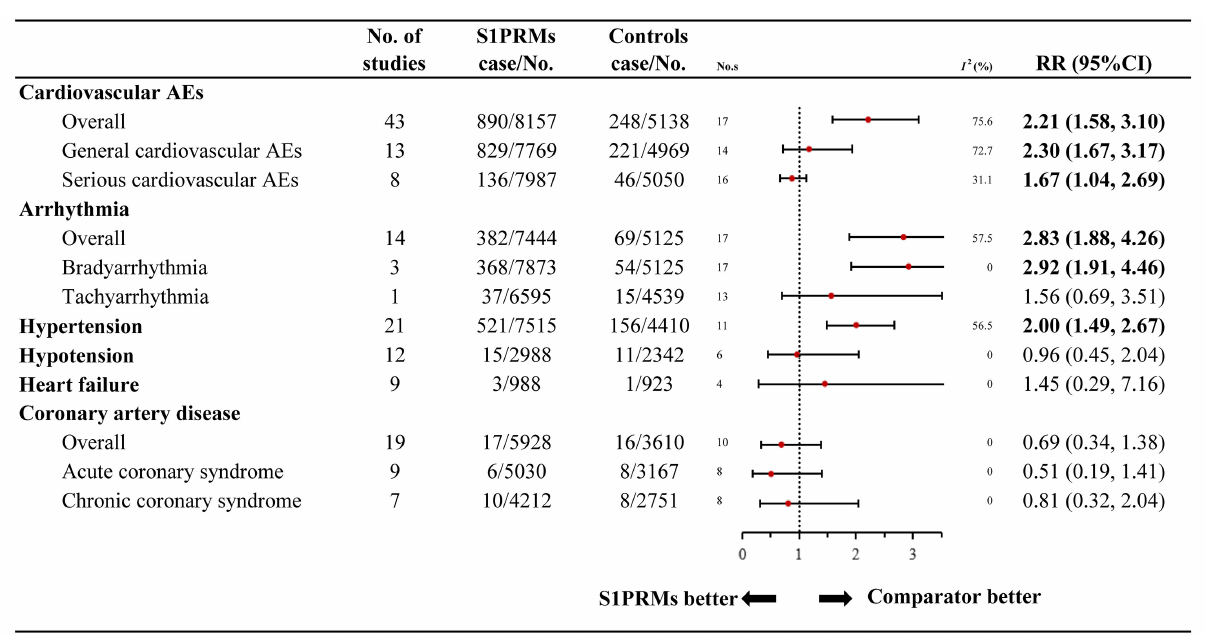
FIGURE 2 | Relative risk of cardiovascular adverse events reported for S1PRMs in comparison to the control treatment. AEs, adverse events; I 2 , heterogeneity; No. s, numbers of studies; RR, relative risk; 95% CI, 95% con fi dence interval; S1PRMs, sphingosine-1-phosphate receptor